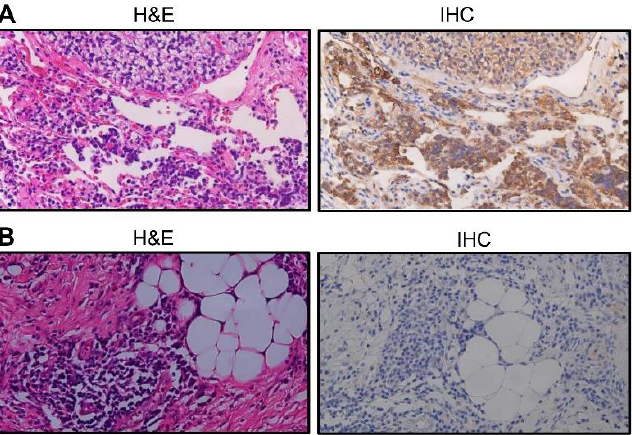
Figure 2. Immunohistochemistry with the anti-GPR64 antibody. ( A ) High expression (Ewing sarcoma tissue samples). Density = 3, Intensity = 2, Total Score = 5. ( B ) Representative data of negative expression (MPNST tissue samples). Density = 0, Intensity = 0, Total Score = 0. IHC, immunohistochemistry; H&E, hematoxylin and eosin.